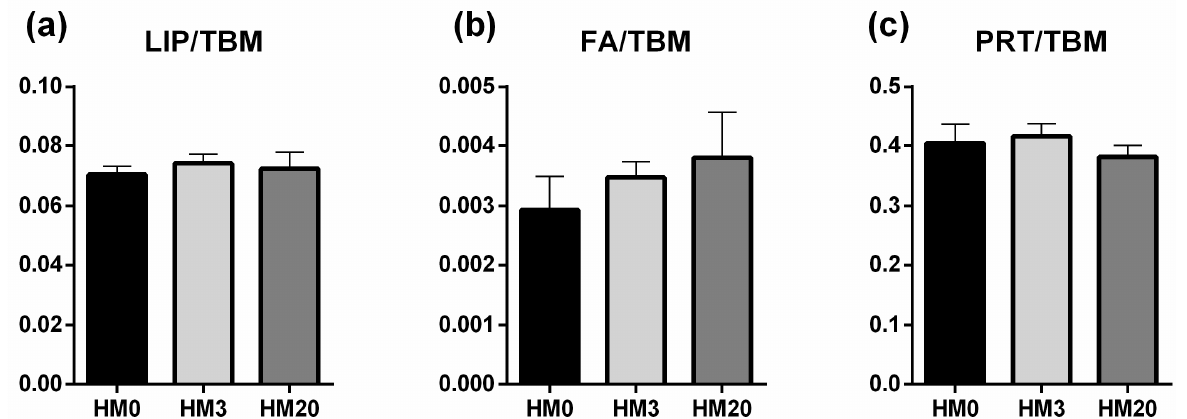
Figure 4. Biochemical composition of liver samples of rainbow trout fed the experimental diets. Statistical analysis of ( a ) LIP/TBM (relative amount of lipids), ( b ) FA/TBM (relative amount of fatty acids), and ( c ) PRT/TBM (relative amount of proteins) band area ratios was performed. Values are shown as mean ± SD ( n = 9).